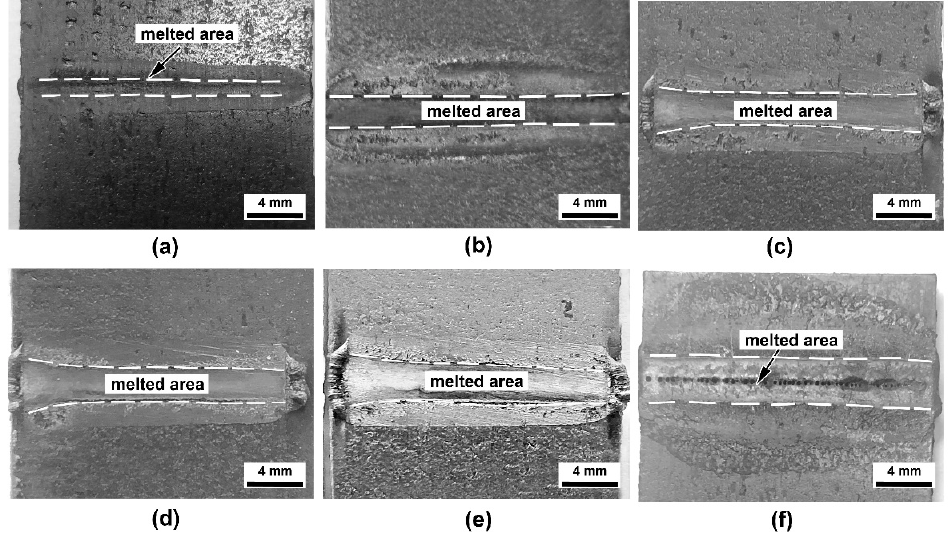
Figure 6. The fracture surface of CFRP at different welding speed: ( a ) 16 mm/s, ( b ) 14 mm/s, ( c ) 12 mm/s, ( d ) 10 mm/s, ( e ) 8 mm/s, and ( f ) 6 mm/s.